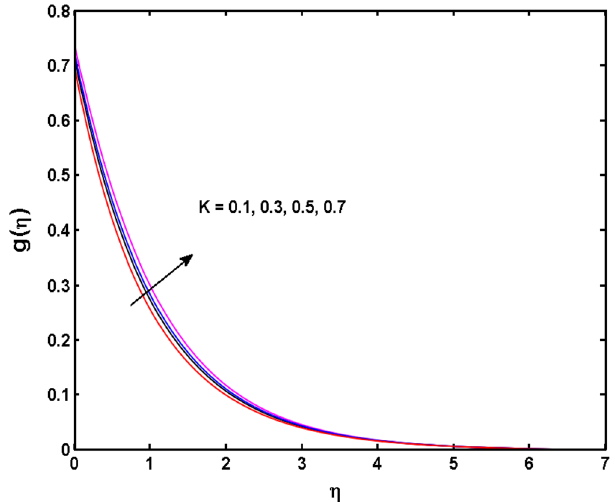
Figure 4. Variations of K to g (η) .